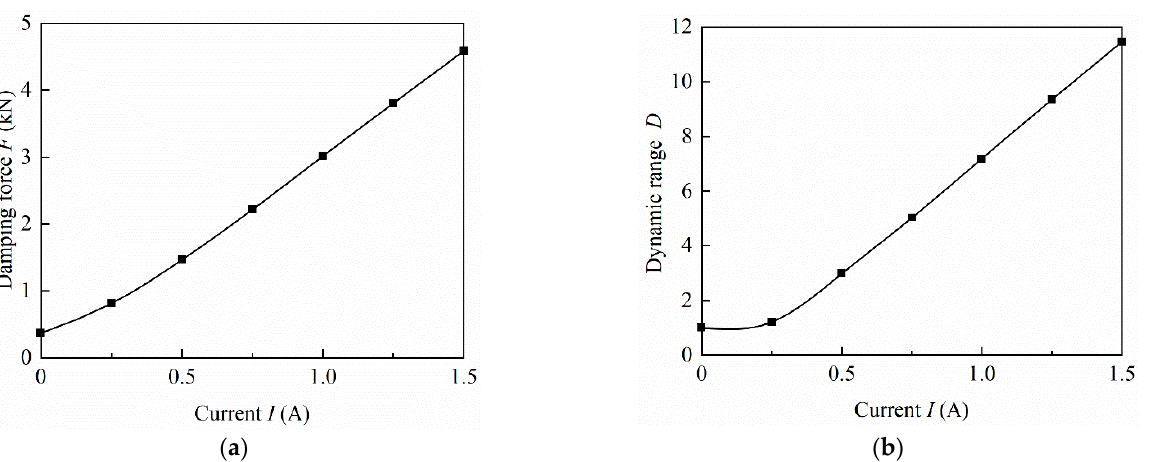
Figure 7. Damping characteristics of the initial MR damper. ( a ) Damping force; ( b ) dynamic range.